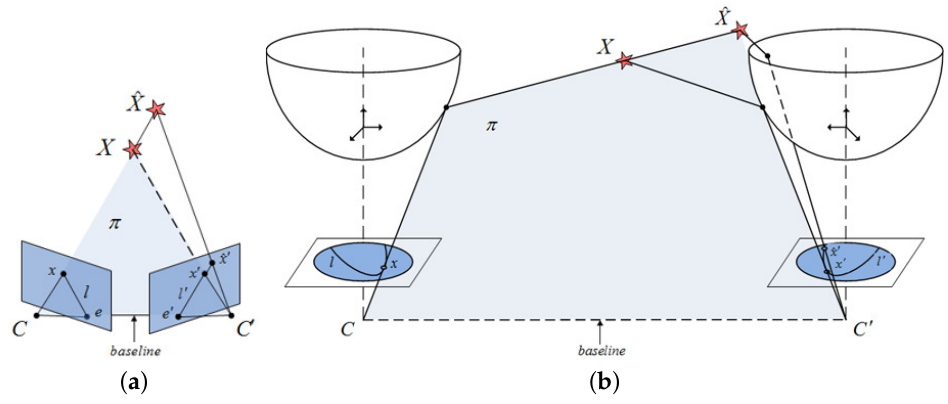
Figure 3. Epipolar constraint adaption: ( a ) planar reference system; ( b ) adaption to our omnidirectional reference